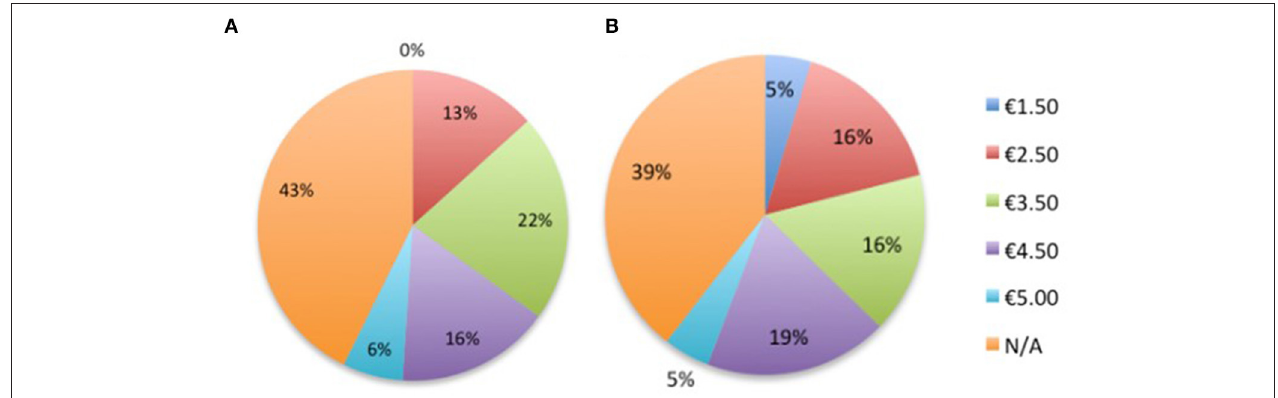
FIGURE 4 | The percentage of respondents and their willingness to pay an absolute price for cockerel meat burgers in (A) Highly educated woman ( n = 143) and (B) Remaining group of respondent ( n = 86).